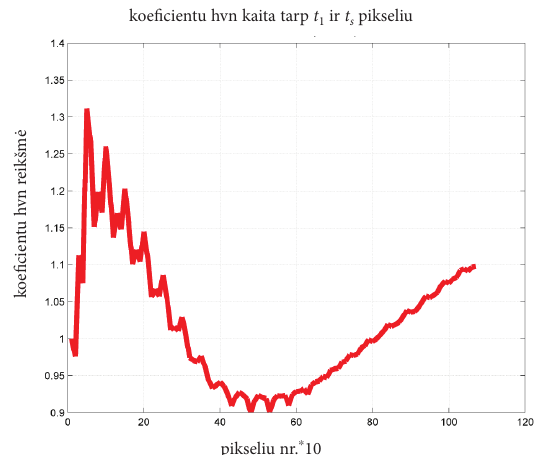
15 pav . Patologinių moteriškųjų ląstelių pirmosios 21-osios chromosomos skaitmeninio vaizdo tenzoriaus vektorinės kovariacijos koeficiento kaita Fig. 15 . Change of the vector covariance coefficient of digital image tenzor of the abnormal female first chromosome 21 in